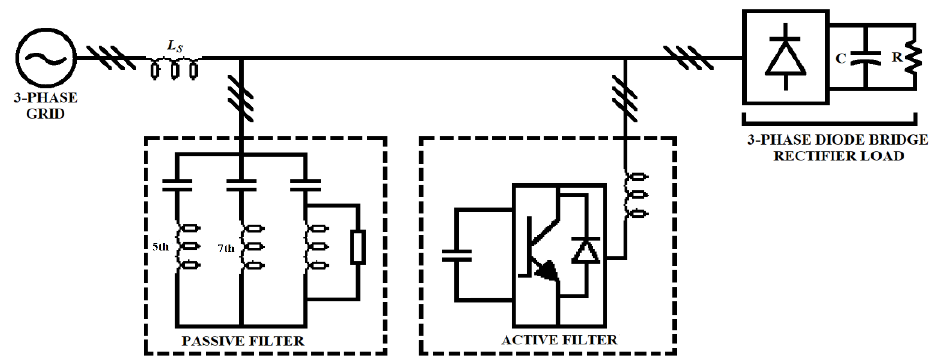
Figure 6. The schematic of HPF